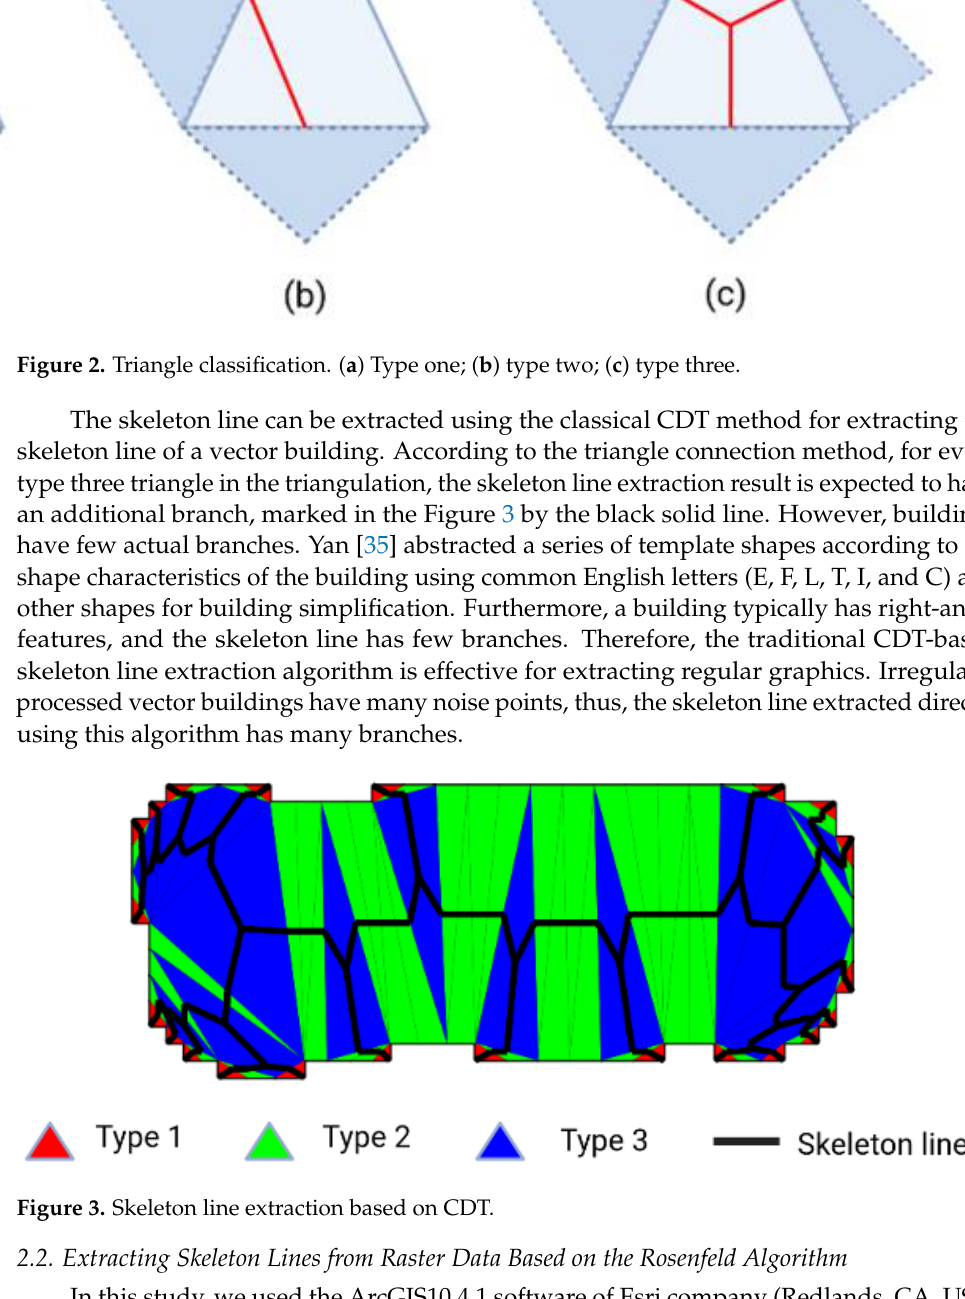
Figure 3. Skeleton line extraction based on CDT. 2.2. Extracting Skeleton Lines from Raster Data Based on the Rosenfeld Algorithm In this study, we used the ArcGIS10.4.1 software of Esri company (Redlands, CA, USA) to rasterize vector data. Many skeleton line extraction algorithms have been devel- oped based on raster data. In practical applications, the skeleton line extracted from raster data must have the width of a single pixel and must not change the topology and connec- tivity of the original building [27]. The fast parallel thinning algorithm based on the ZS method is commonly used at present. However, the thinning result of this algorithm